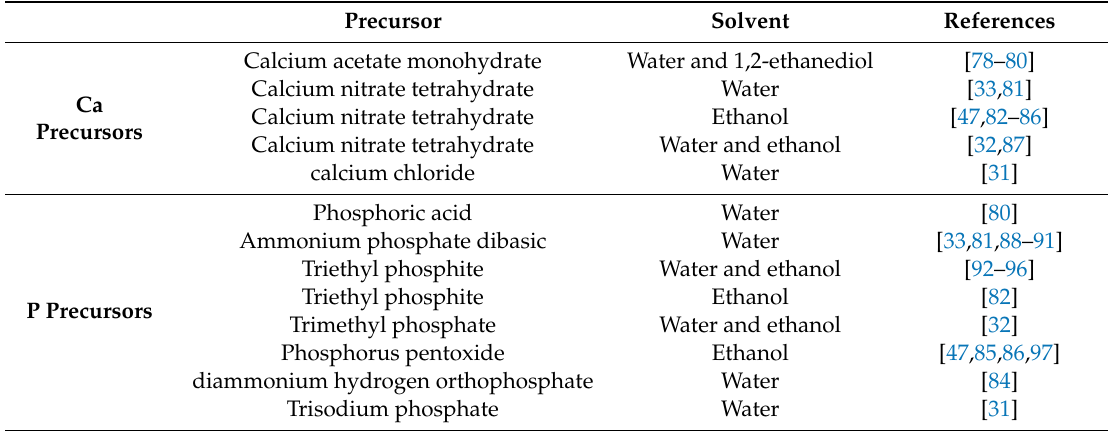
Table 3. Precursors and solvent of